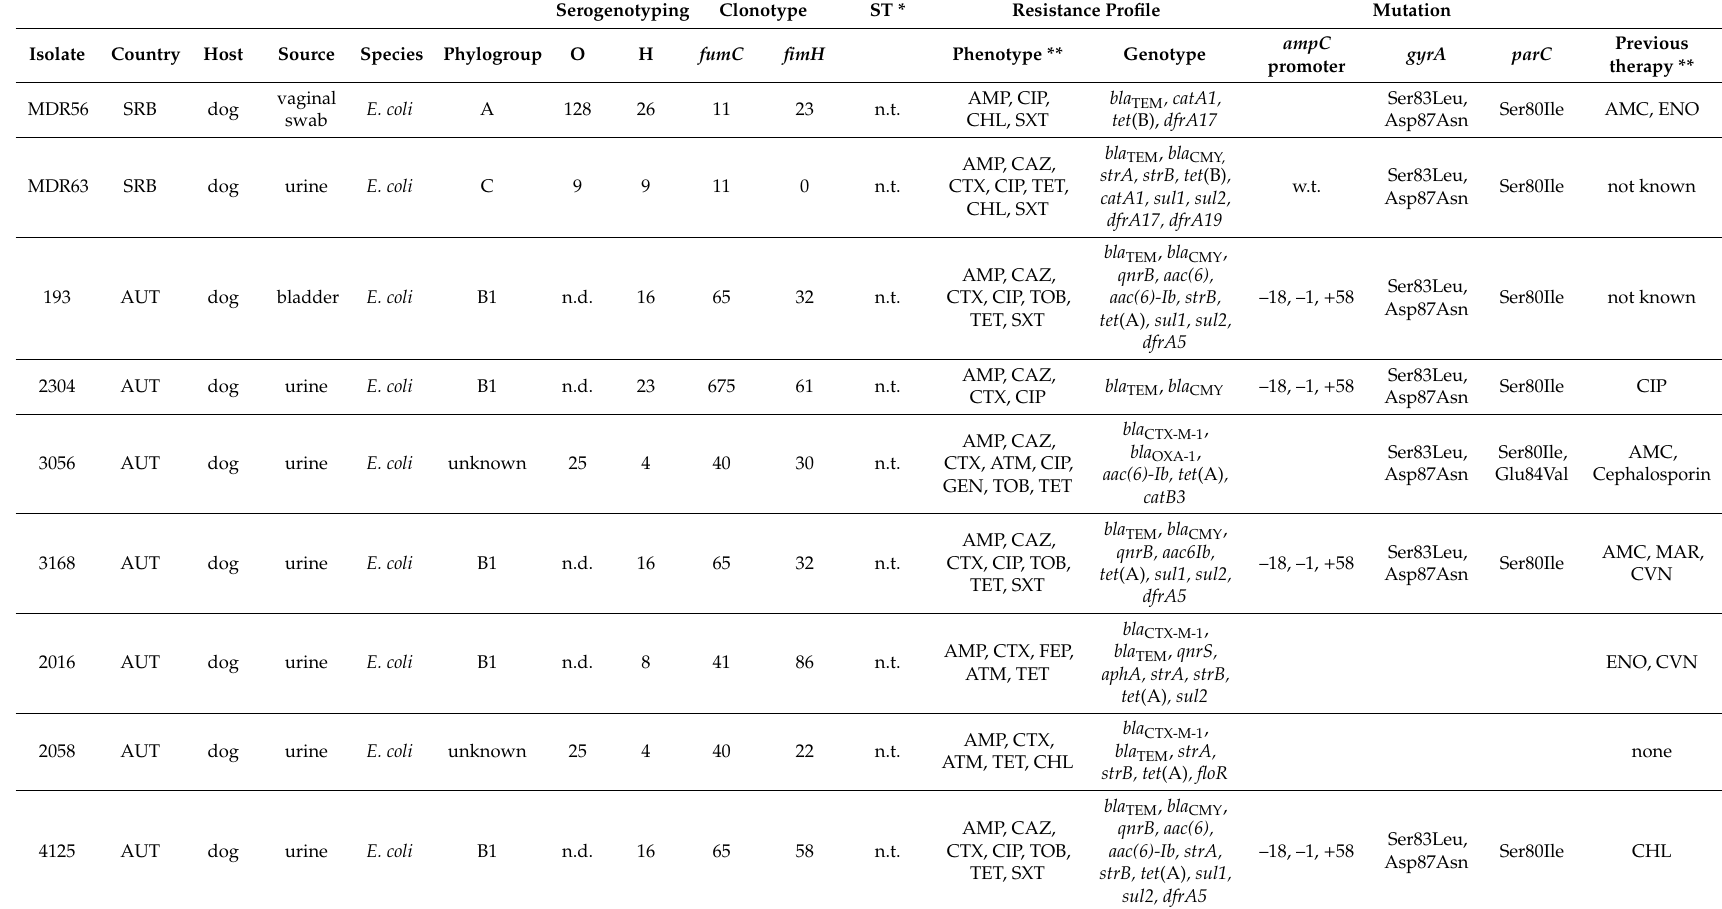
Table 1. Molecular characterization and resistance to antibiotics of canine and feline E. coli isolated from urogenital infections and originating from Austria (AUT) and Serbia